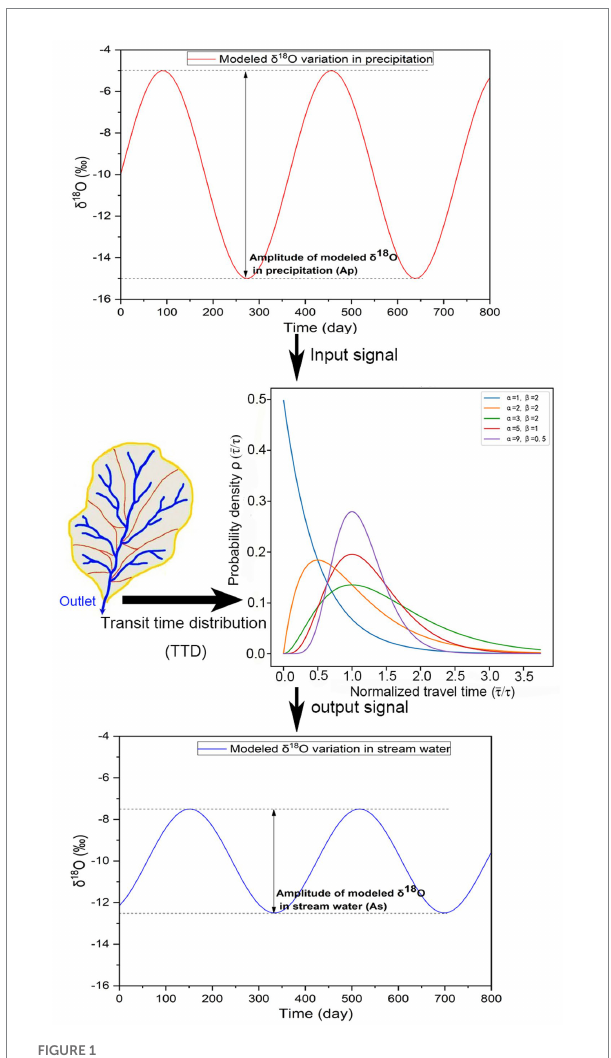
FIGURE 1 Conceptual scheme showing the Fyw estimation based on the lumped parameter